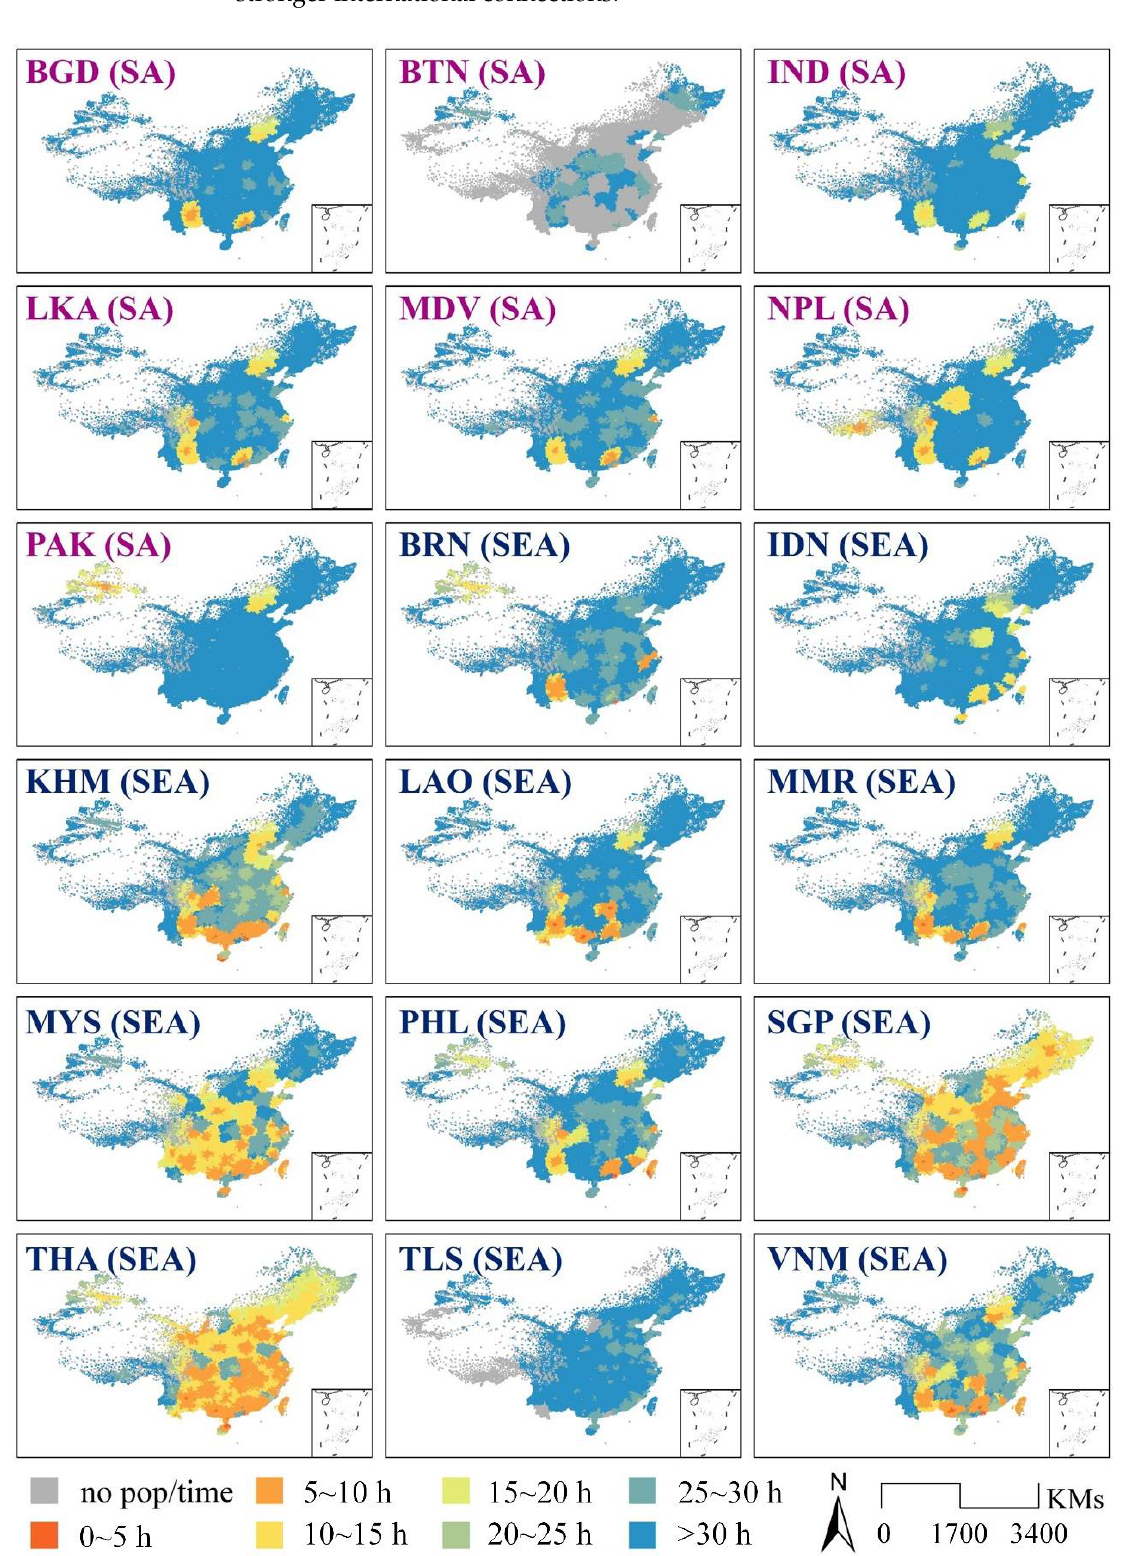
Figure 6. The weighted-average travel time from 44,682 China residential areas to each SA&SEA country. The figure is under the WGS-84 geographical coordinate system.